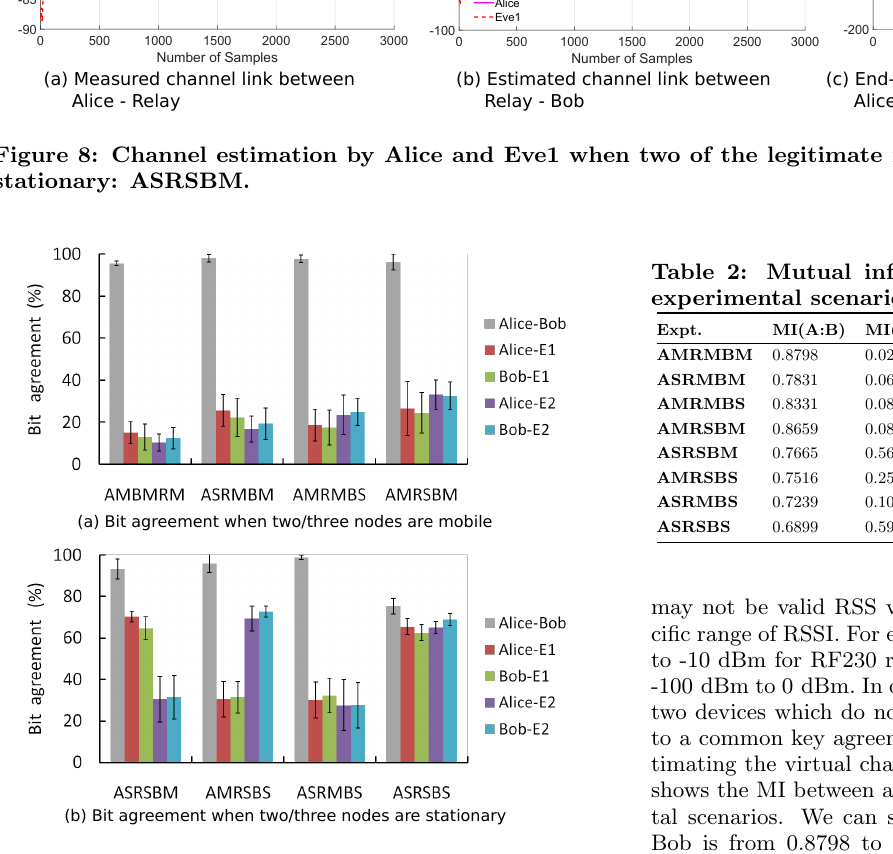
Figure 7: Bit agreement of all the devices for various scenarios.